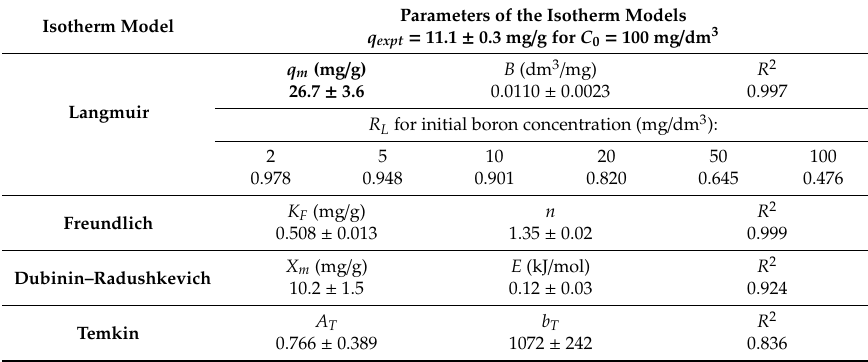
Table 2. Parameters of Langmuir, Freundlich, Dubinin-Radushkevich, and Temkin isotherms on La-CTS hydrogel beads at 20 ± 1 ◦ C.